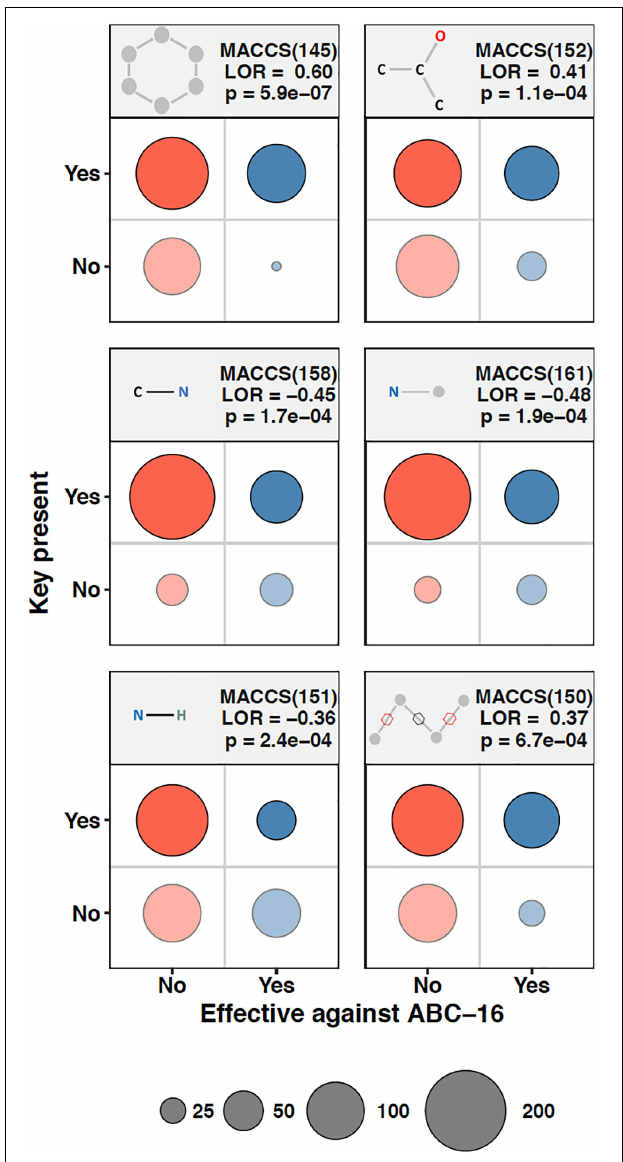
FIGURE 2 | Chemical substructures significantly enriched or depleted in drugs that are effective against ABC-16. 2 × 2 contingency tables relating relative efficacy against ABC-16 and presence of substructure are given for six substructures. The number of drugs in each quadrant are represented by circle size. Also shown are the log-odds ratios (LOR) and the associated p -values calculated using Fisher’s Exact Test. When adjusted by Benjamini-Hochberg procedure, the six substructures shown exhibited FDR <